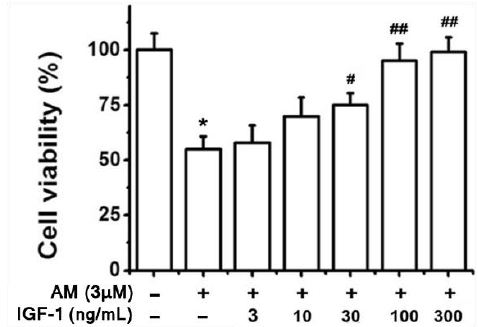
Figure 6. IGF-1 pretreatment preserves RGC viability in the presence of AM. RGC cells received varying concentrations of IGF-1 and then exposed to 3 µ M AM for 24 h. Cell viability was determined via the MTT assay. Results show the mean ± SEM of five independent experiments. * p < 0.05 compared with control, # p < 0.05 compared with amiodarone, ## p < 0.01 compared with amiodarone